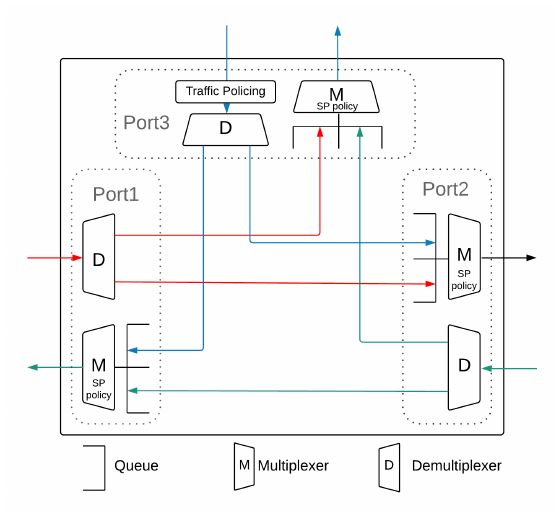
Figure 3. T-AeroRing internal